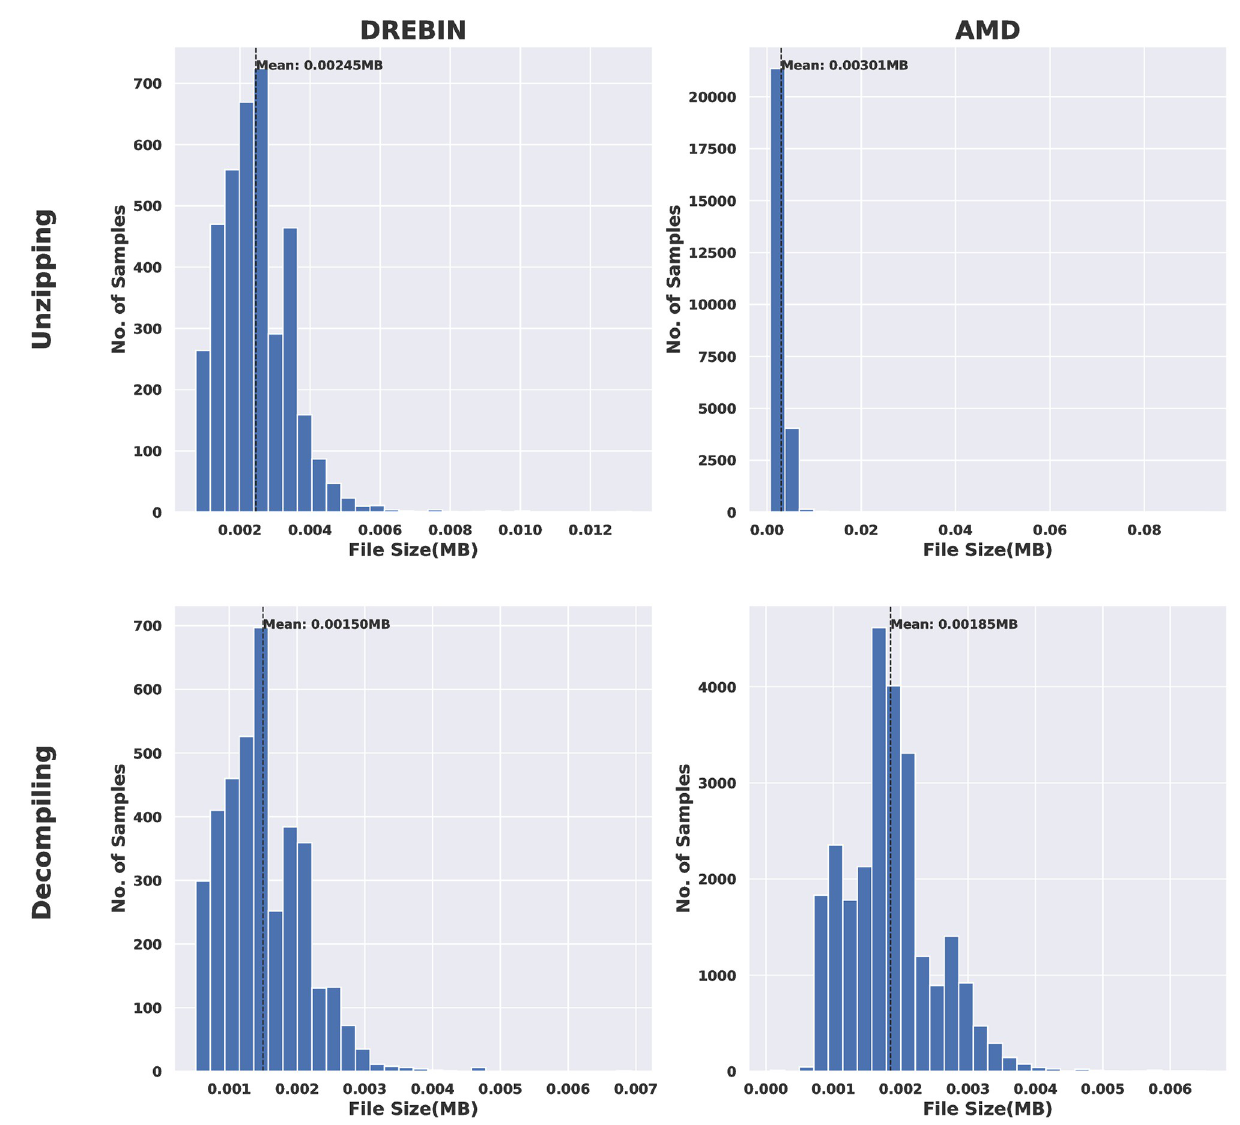
Fig 8. DREBIN VS AMD in terms of file size of AM/DAM